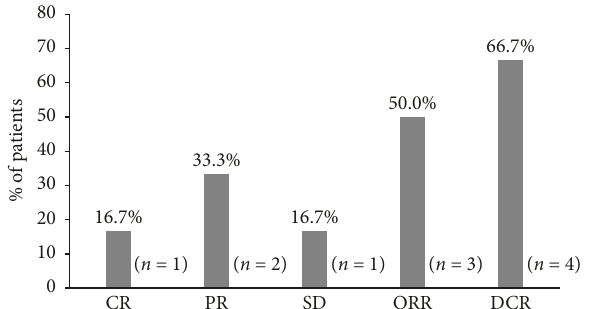
Figure 1: Efficacy of NDLS-based chemotherapy for the treatment of sarcoma in metastatic setting ( n � 6). CR: complete response; DCR: disease control rate; NDLS: nanosomal docetaxel lipid suspension; ORR: overall response rate; PR: partial response. Disease progression was reported in 2 patients.